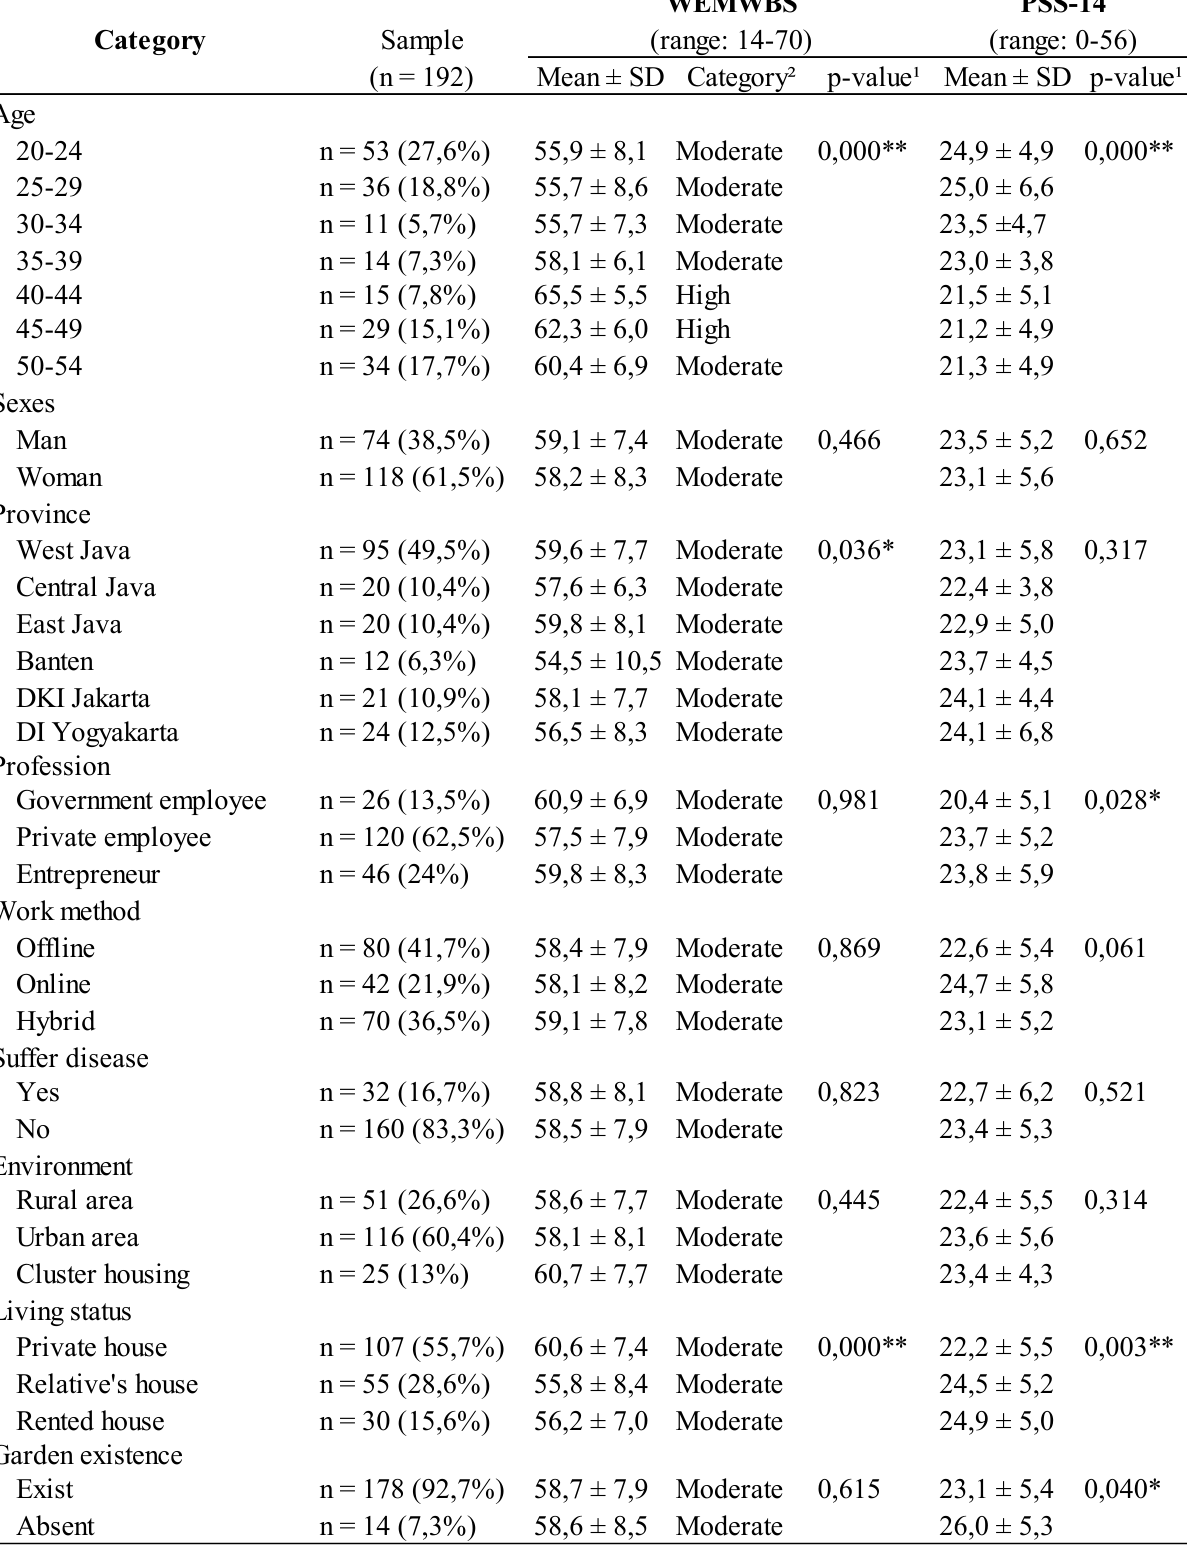
Table 6. Sociodemographic characteristics and their relationship to psychological